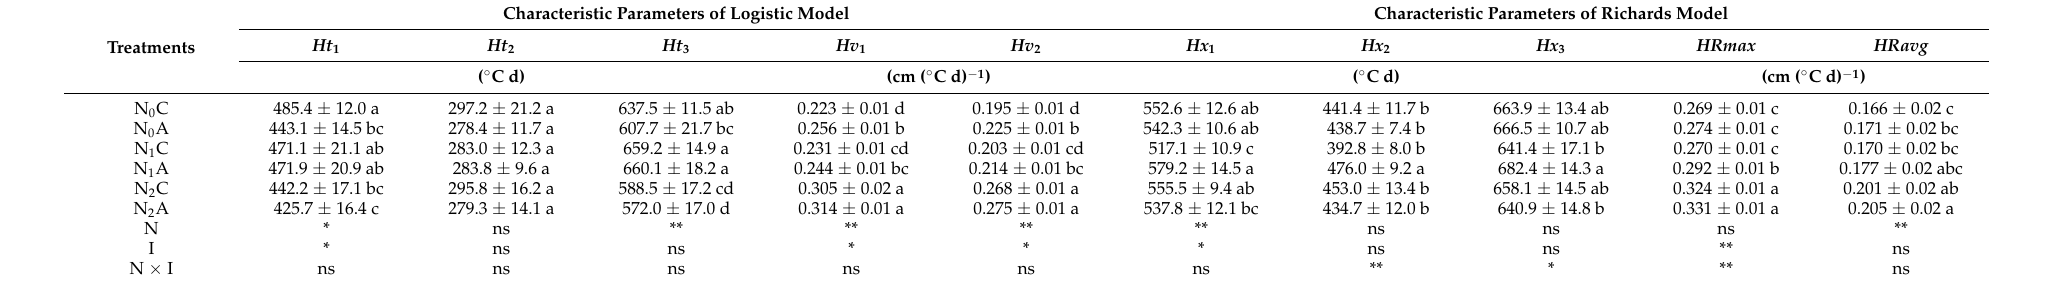
Table 2. Characteristic parameters describing plant height dynamic process of tomato under different treatments.